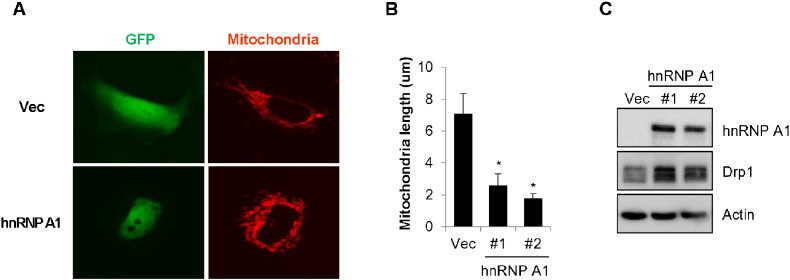
Over-expression of hnRNP A1 enhances expression of Drp1.SK-N-MC cells stably expressing control GFP (SK-N-MC/GFP) or GFP-fused-hnRNP A1 (SK-N-MC/GFP-hnRNP A1, #1, #2) were stained with a mito-tracker to image mitochondria. Then the mitochondria morphology was monitored using a fluorescence microscope. (A) Representative fluorescence images of mitochondrial morphology by over-expression of pEGFP (Vec) or pEGFP-hnRNP A1 (#1 and #2). (B) The mitochondrial length was determined by using a ‘Cell Sense Standards’ software (Olympus, Hamburg, Germany) with a fluorescence microscope. (C) The expressions of hnRNP A1 (#1, #2) and Drp1 were confirmed by Western blot analysis. Data are represented as the mean ± SEM (n > 3, and *p < 0.05 value).